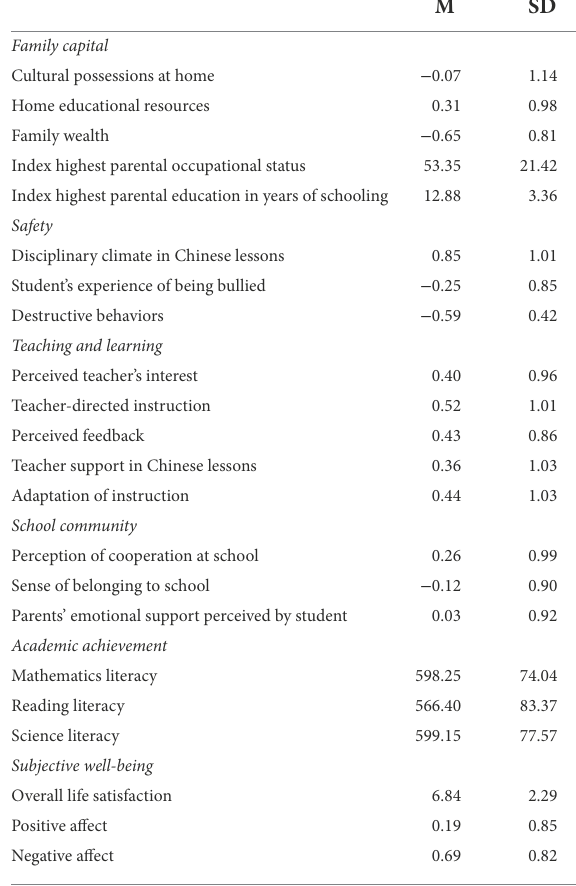
TABLE 5 Descriptive statistics of subjective well-being and its influencing